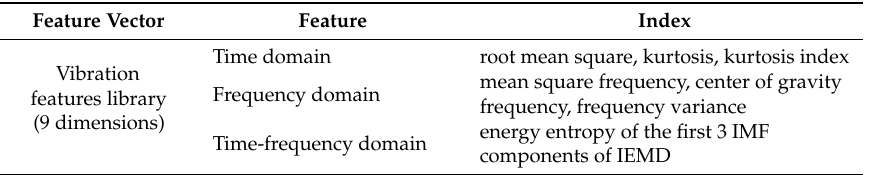
Table 3. The indexes of feature vector for vibration